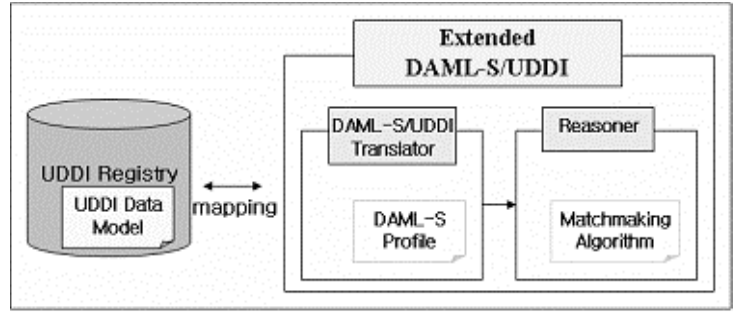
Figure 4. System Architecture of the Matchmaking